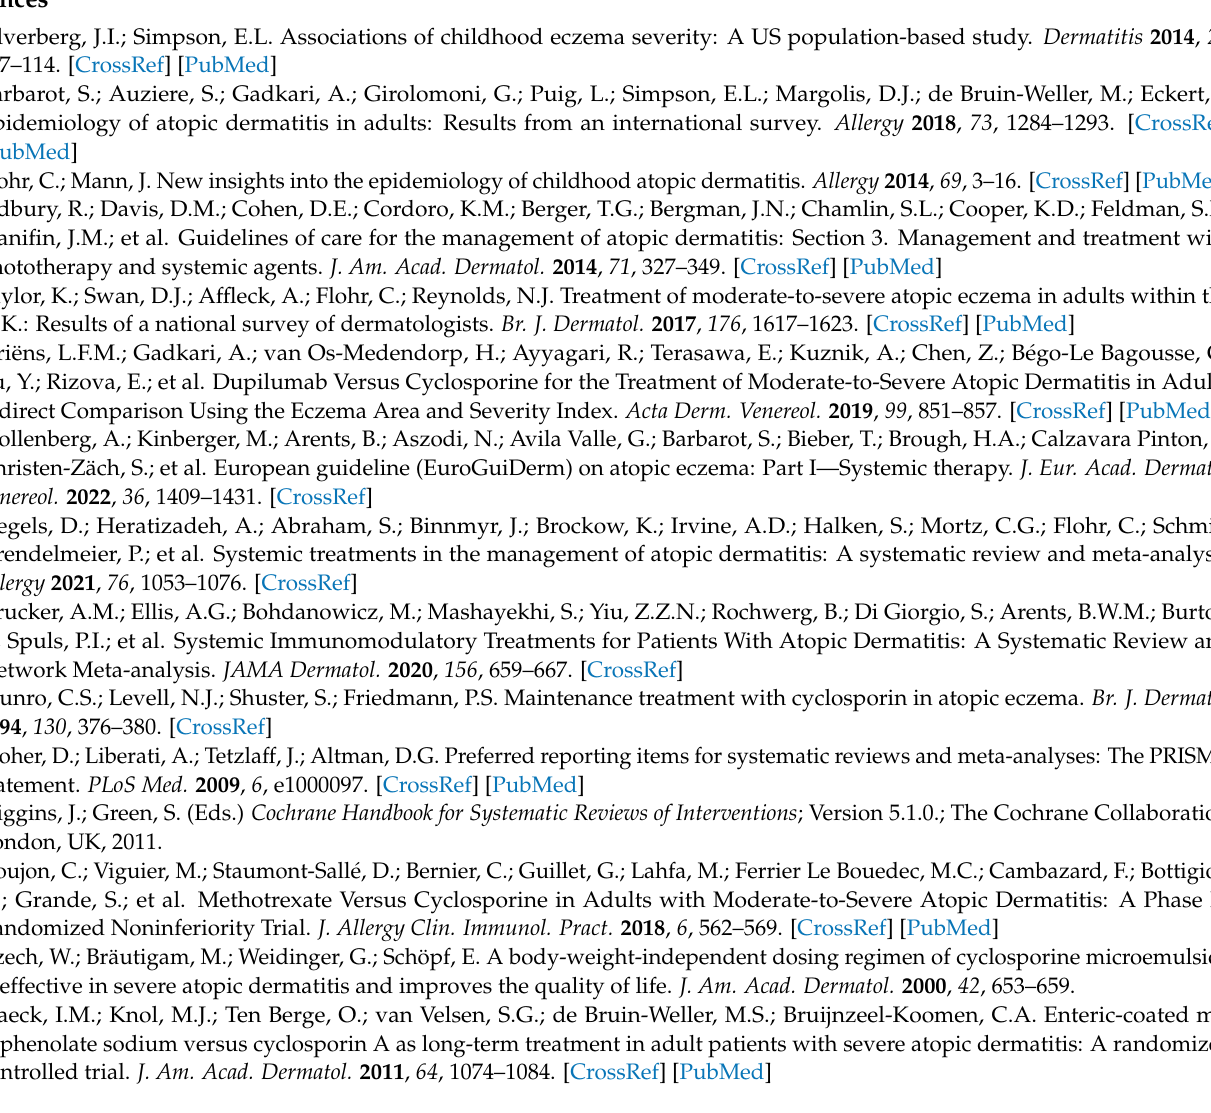
Figure S1: Sensitivity analysis of the adverse